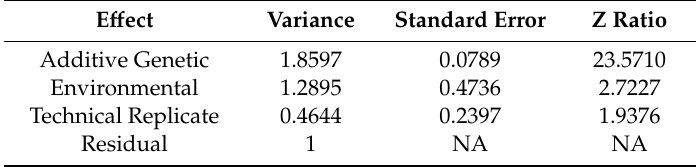
Figure 1. Violin plots show the distribution of physical dormancy for maternal lines grown in each site-year. Boxplots embedded within the violin plots indicate means, 25th and 75th percentiles, and outliers for each site-year. The complete variance was observed among site-years and maternal lines, with extreme values, including 0 and 100% physical dormancy. Table 2. Additive genetic variance, environmental variance, technical replicate variance, and residual variance of physical dormancy using an animal model.